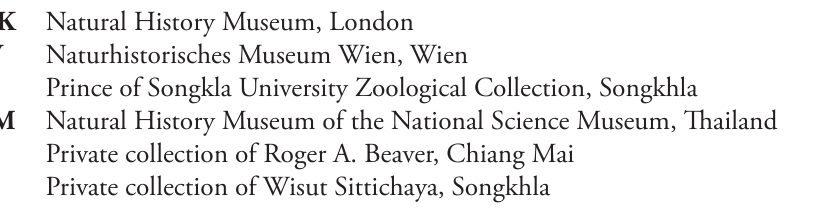
Type material . Holotype: female, THAILAND, Hala-Bala Wildlife Sanctuary, Nar- athiwat Province, lowland tropical rainforest, 5°47'44"N, 101°50'07"E, 01.iii.2014, ethanol baited trap (W. Sittichaya) (NHMW). Paratypes: 12 females, same data as